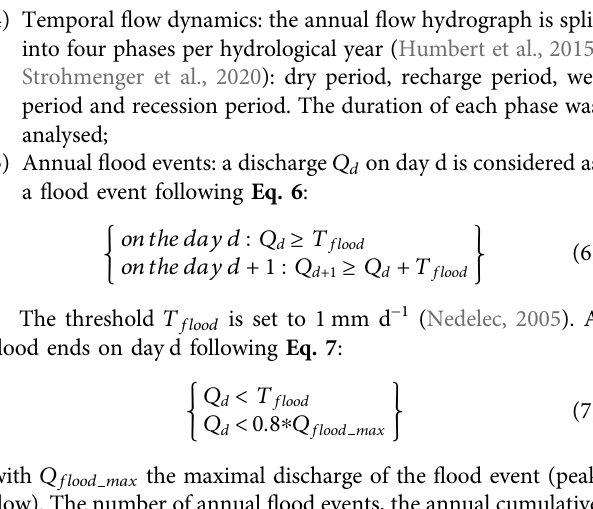
Frontiers in Environmental Science |